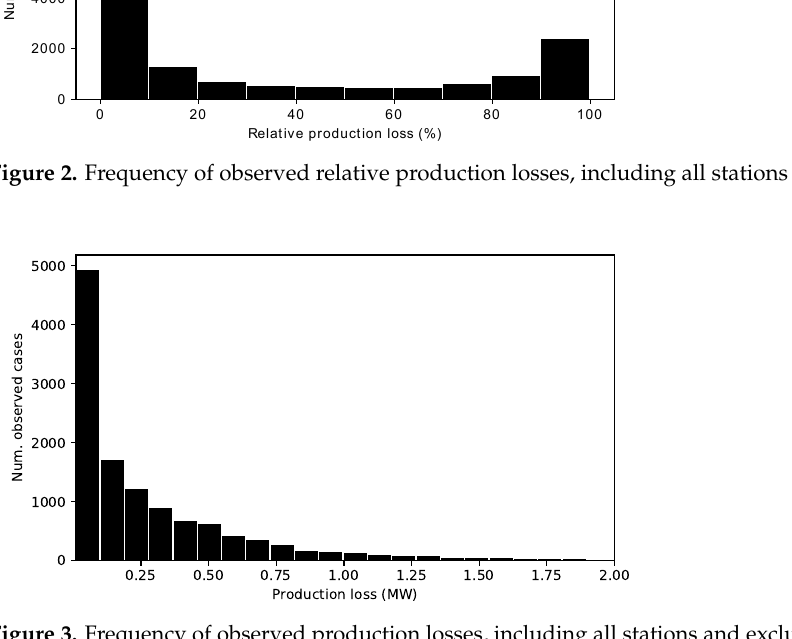
Figure 3. Frequency of observed production losses, including all stations and excluding zero produc- tion loss